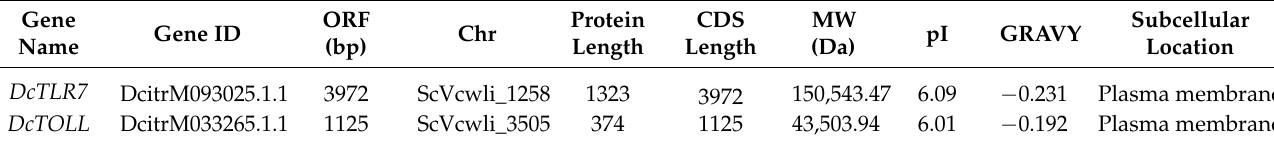
Table 1. Characterization of identified TLR genes in Diaphorina citri .